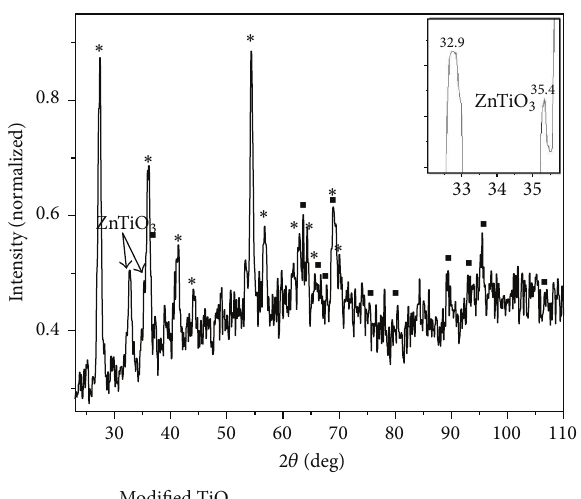
Figure 2: XRD of modified TiO 2 (hybrid ZnO/TiO 2 composite) nanopowder. The symbol “ ∗ ” identifies characteristic phases of rutile, while ZnO peaks are represented by “ ◼ ”. In the inset, peaks confirm the presence of ZnTiO 3 .